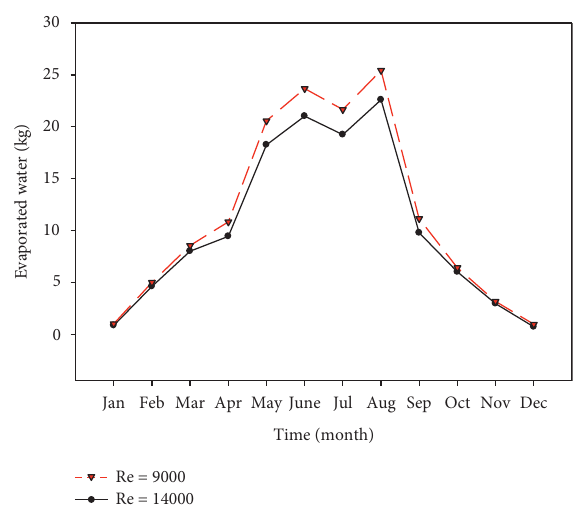
Figure 18: Effect of Re on monthly evaporated water for reactor inclined at 1 ° , water depth � 5.6mm, and aspect ratio �